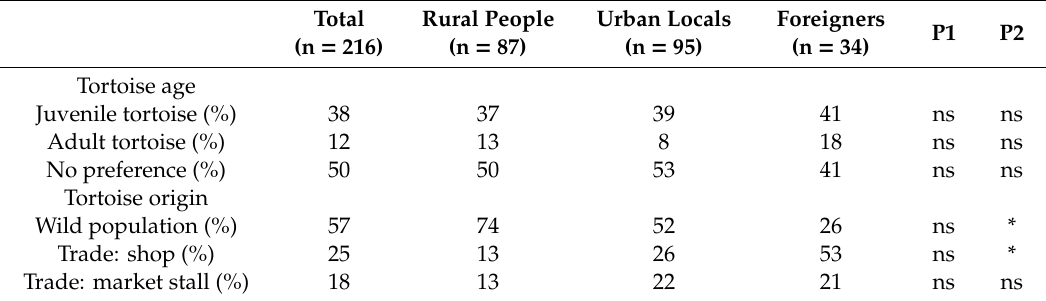
Table 3. Tortoise age and origin preference of those people who did not have a tortoise. Di ff erences between rural people and urban locals (P1) and rural people and foreigners (P2) according to Chi-square tests; p -values are shown: ns (not significant), * ( p < 0.05). Total Rural People (n = 216) (n =